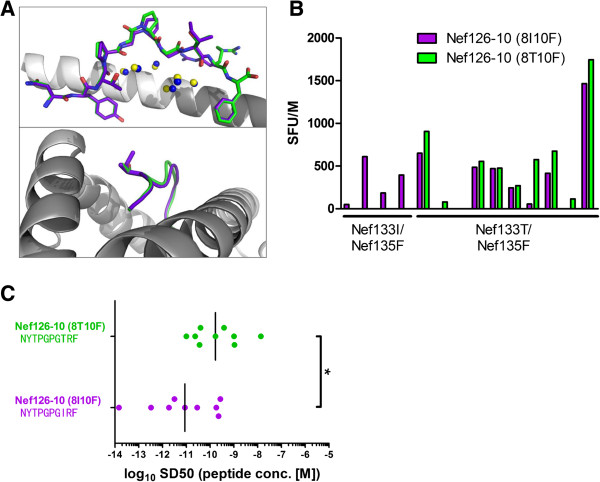
Impact of I133T mutation on the structures of pHLA and responding T cell subsets. (A) Top; Side view of structures of the Nef126-10(8I10F) (colored purple) and Nef126-10(8T10F) (colored green) is shown. Superimposition is based on the HLA-A*24:02 peptide binding domain. Water molecules are represented in blue and yellow spheres for the Nef126-10(8I10F) and Nef126-10(8T10F) epitopes, respectively. The number of peptide residues is labeled in black through P1 to P10. The HLA-A*24:02 is represented as a dark grey (Nef126-10(8T10F) and light grey cartoon. (B) The presence of the responses to each peptide was examined by ex vivo ELISpot assay. A pair of sticks, Nef126-10(8I10F) (purple) and Nef126-10(8T10F) (green), represents the average SFU of duplicate wells to each peptide in one patient. Four individuals on the left side harbored 133I/135F mutant and 10 individuals on the right side harbored 133T/135F mutant. (C) Functional avidity curve was drawn for 9 subjects who harbored Nef133T/135F sequence. From the curve, SD50 was calculated and projected in this chart. Nef126-10(8I10F)-specific CTL responses (purple) showed significantly higher functional avidity compared to Nef126-10(8T10F) (green). Each point represents functional avidity for specific peptide in one individual. The significance between two groups was calculated by Mann–Whitney U-test; *, p < 0.05.